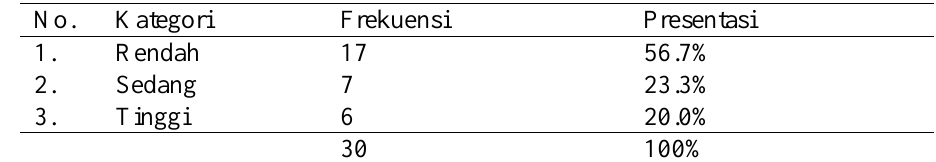
Tabel 4. Stimulus residual pada ODHA di KDS Friendship Plus Kota Kediri No.